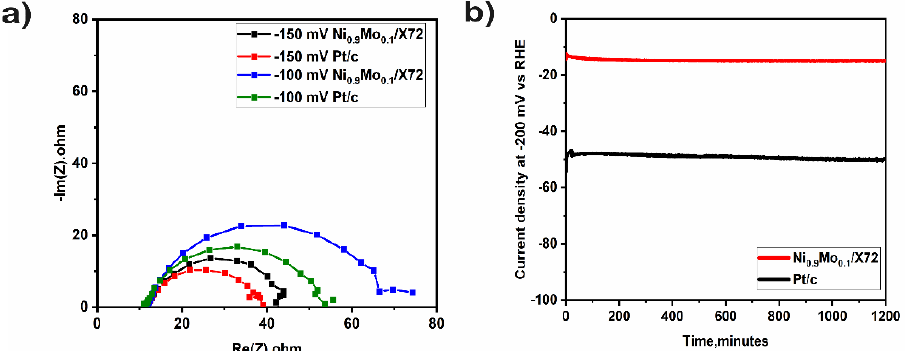
Figure 5. ( a ) Nyquist plot of Ni 0.9 Mo 0.1 and Pt/C in 1 M KOH at − 150 and 150 mV vs. RHE ( b ) Chronoamperometry of Ni 0.9 Mo 0.1 and Pt/C for 24 h in 1 M KOH.